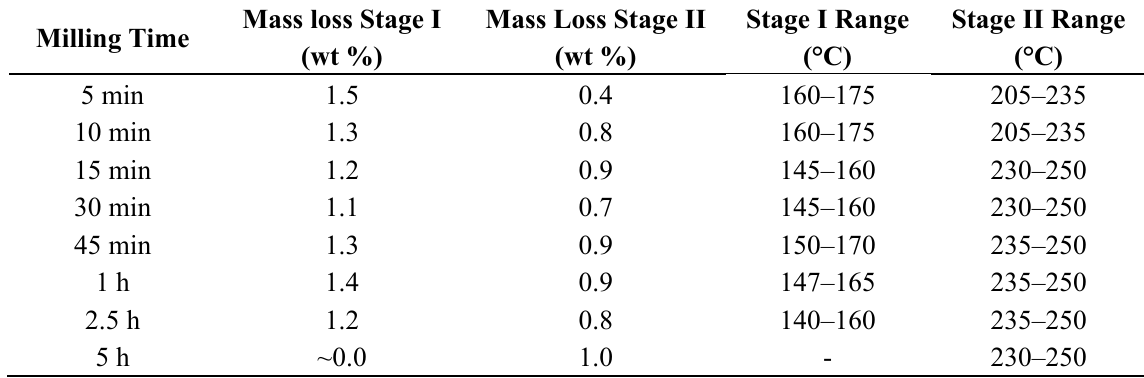
Table 2. Summary of thermal gravimetric analysis (TGA) mass loss (wt %) at Stage I and II of decomposition of hydride nanocomposites after varying milling time and the temperature ranges of both stages.